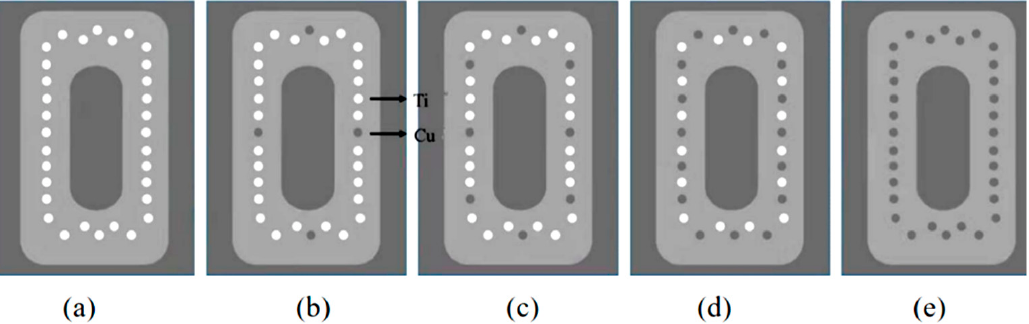
Figure 1. Schematic diagram of Ti-Cu mosaic target with ( a ) 0 Cu rods; ( b ) 4 Cu rods; ( c ) 8 Cu rods; ( d ) 16 Cu rods; and ( e ) 32 Cu